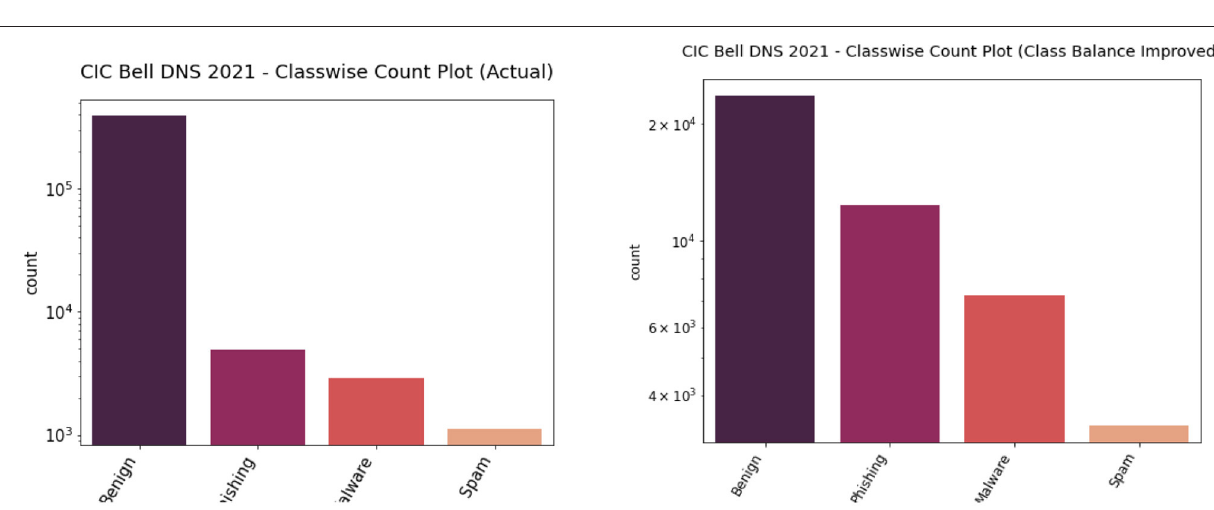
FIGURE 8 | Classwise count plot of actual (left) and class balance improved (right) CIC Bell DNS 2021 dataset.